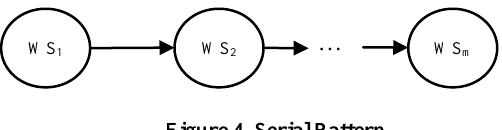
Figure 4. Serial Pattern.